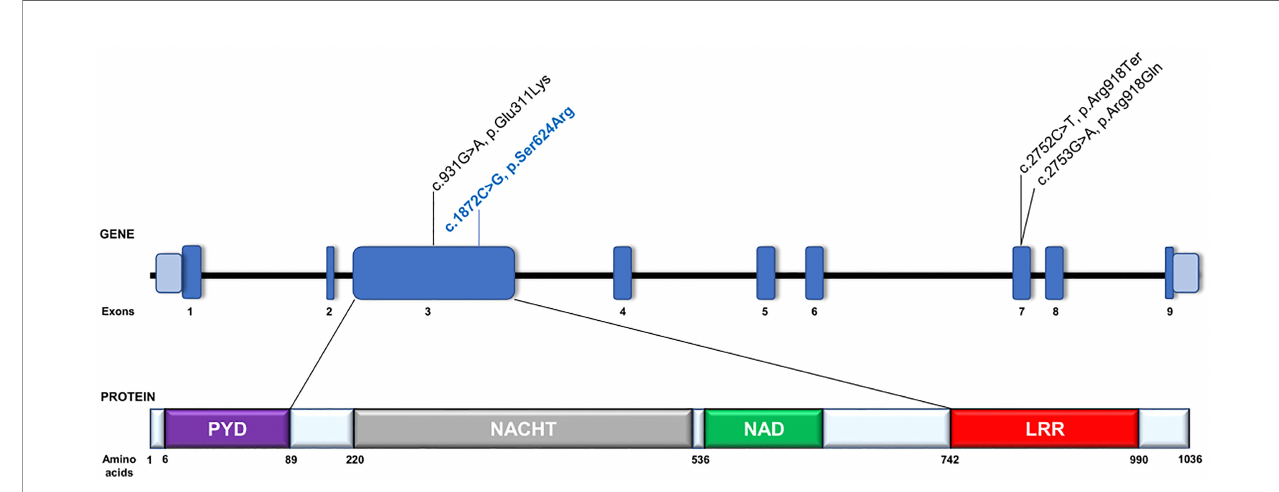
FIGURE 2 | Schematic representation of the NLRP3 gene and its protein organization. Gene and protein structures are depicted based on the canonical transcript NM_001243133.1 and reference protein sequence NP_001230062.1. The NRLP3 protein consists of an N-terminal pyrin domain (PYD), a central nucleotide-binding oligomerization domain (NACHT), a NACHT-associated (NAD) domain, followed by a leucine-rich repeat (LRR) domain at the C terminus. Previously reported NLRP3 pathogenic variants involved in DFNA34 or atypical NLRP3-AID development are in black text. The c.931G>A, p.Glu311Lys variant was previously reported as